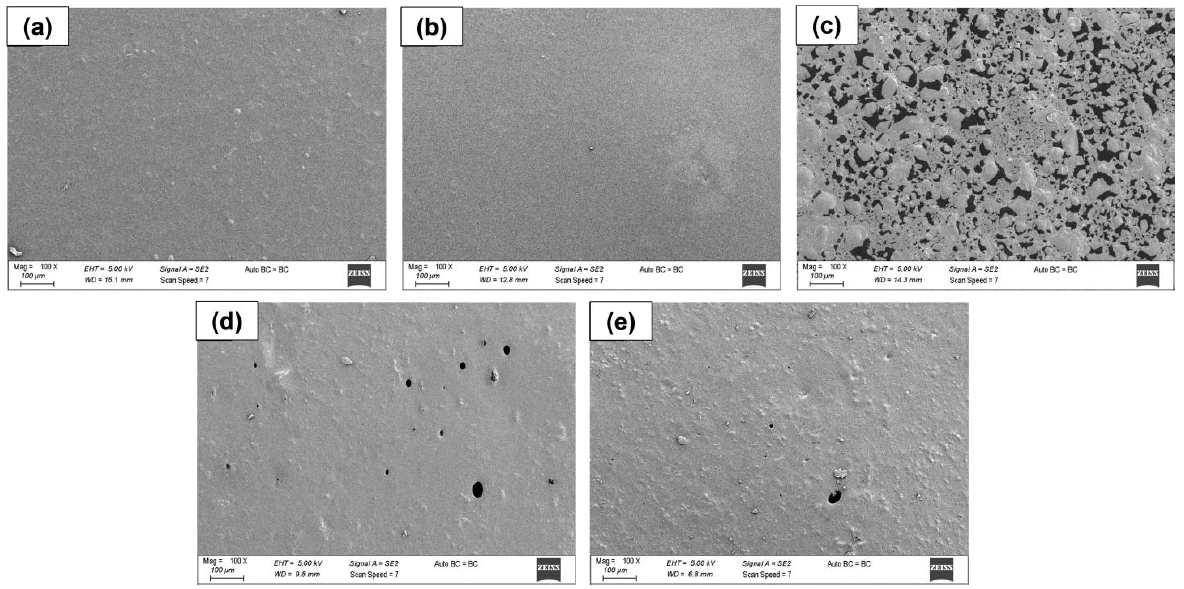
Figure 3. SEM images of the ( a ) PI film, ( b ) PIP film, ( c ) PIP-N1 Pickering film, ( d ) PIP-N3 Pickering film, and ( e ) PIP-N5 Pickering film.